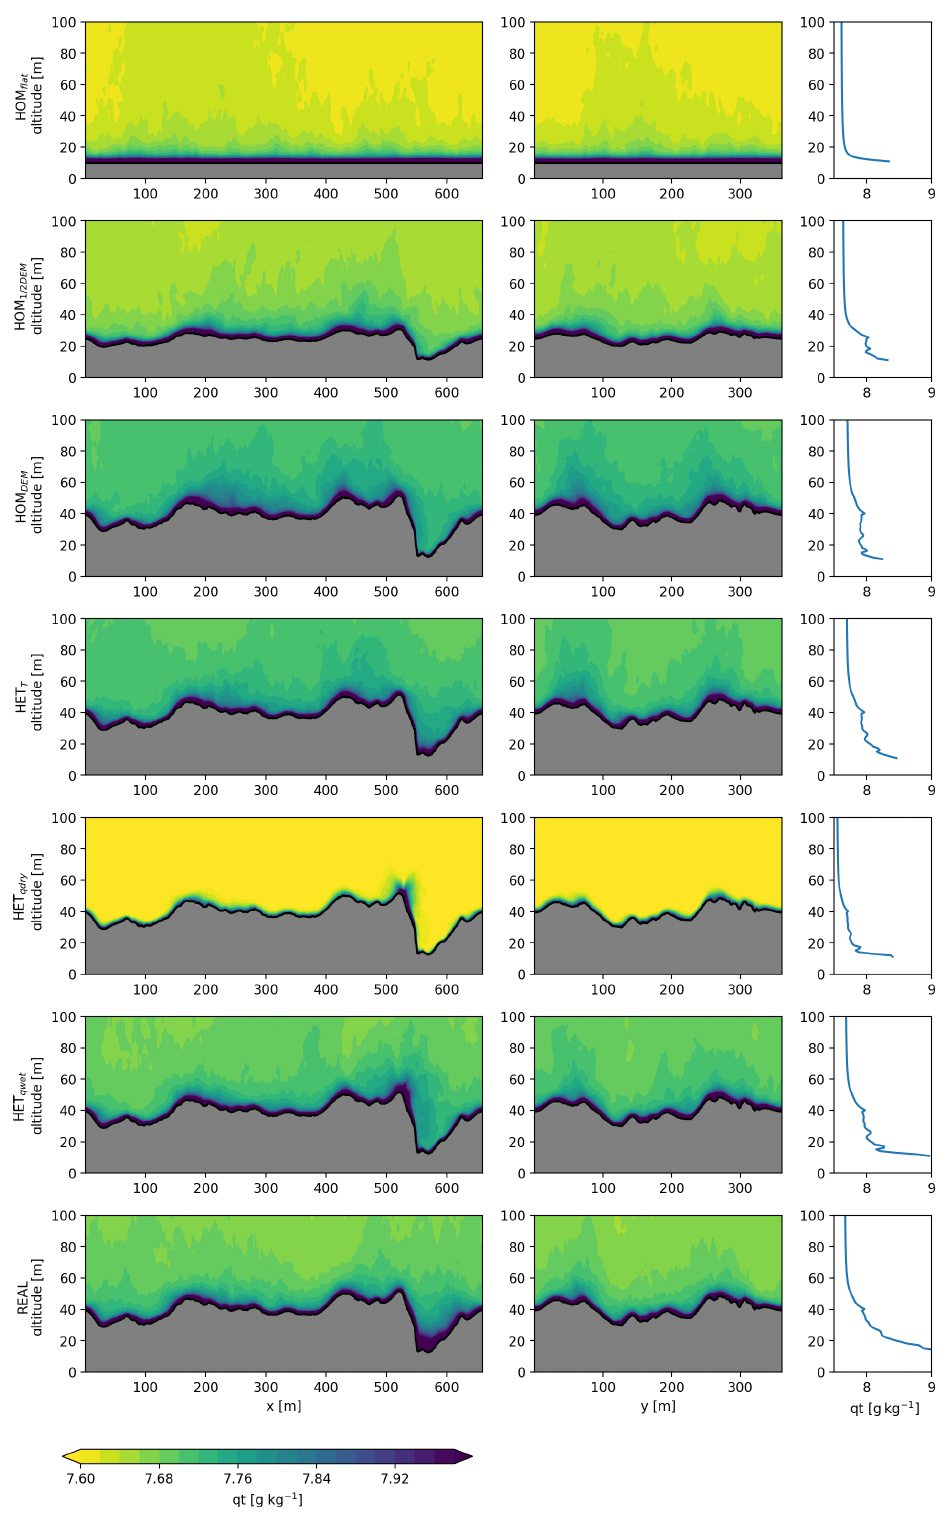
Figure 6. As in Fig. 5 but here for the specific